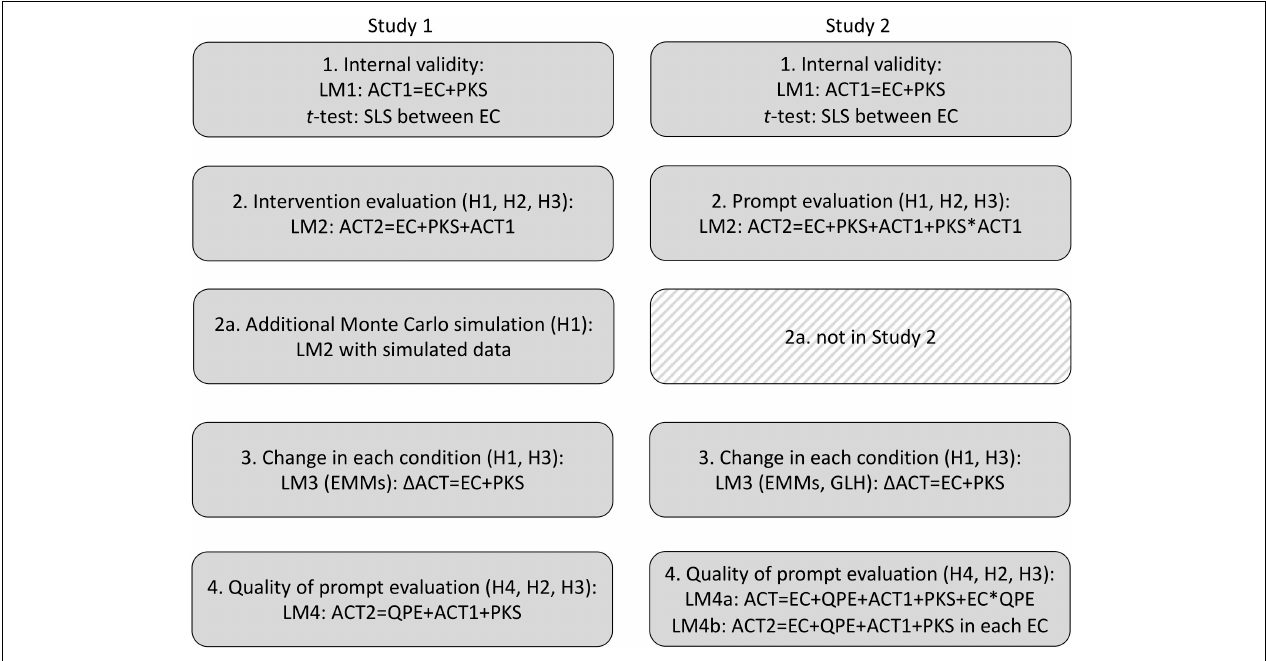
FIGURE 3 | Analysis steps in each study. The figure shows the statistical models and corresponding hypotheses in each analysis step. The linear models are provided in a simplified form, the left-hand side indicates the dependent variables and the right-hand side the regressors, variable names are the same as in “Materials and Methods” section in both studies respectively. Note that in this figure the experimental condition (EC) in Study 2 is considered in a generic form as a single variable and not as a dummy-coded variable with two manifestations. Further abbreviations: EMMs: estimated marginal means, GLH: general linear hypothesis.